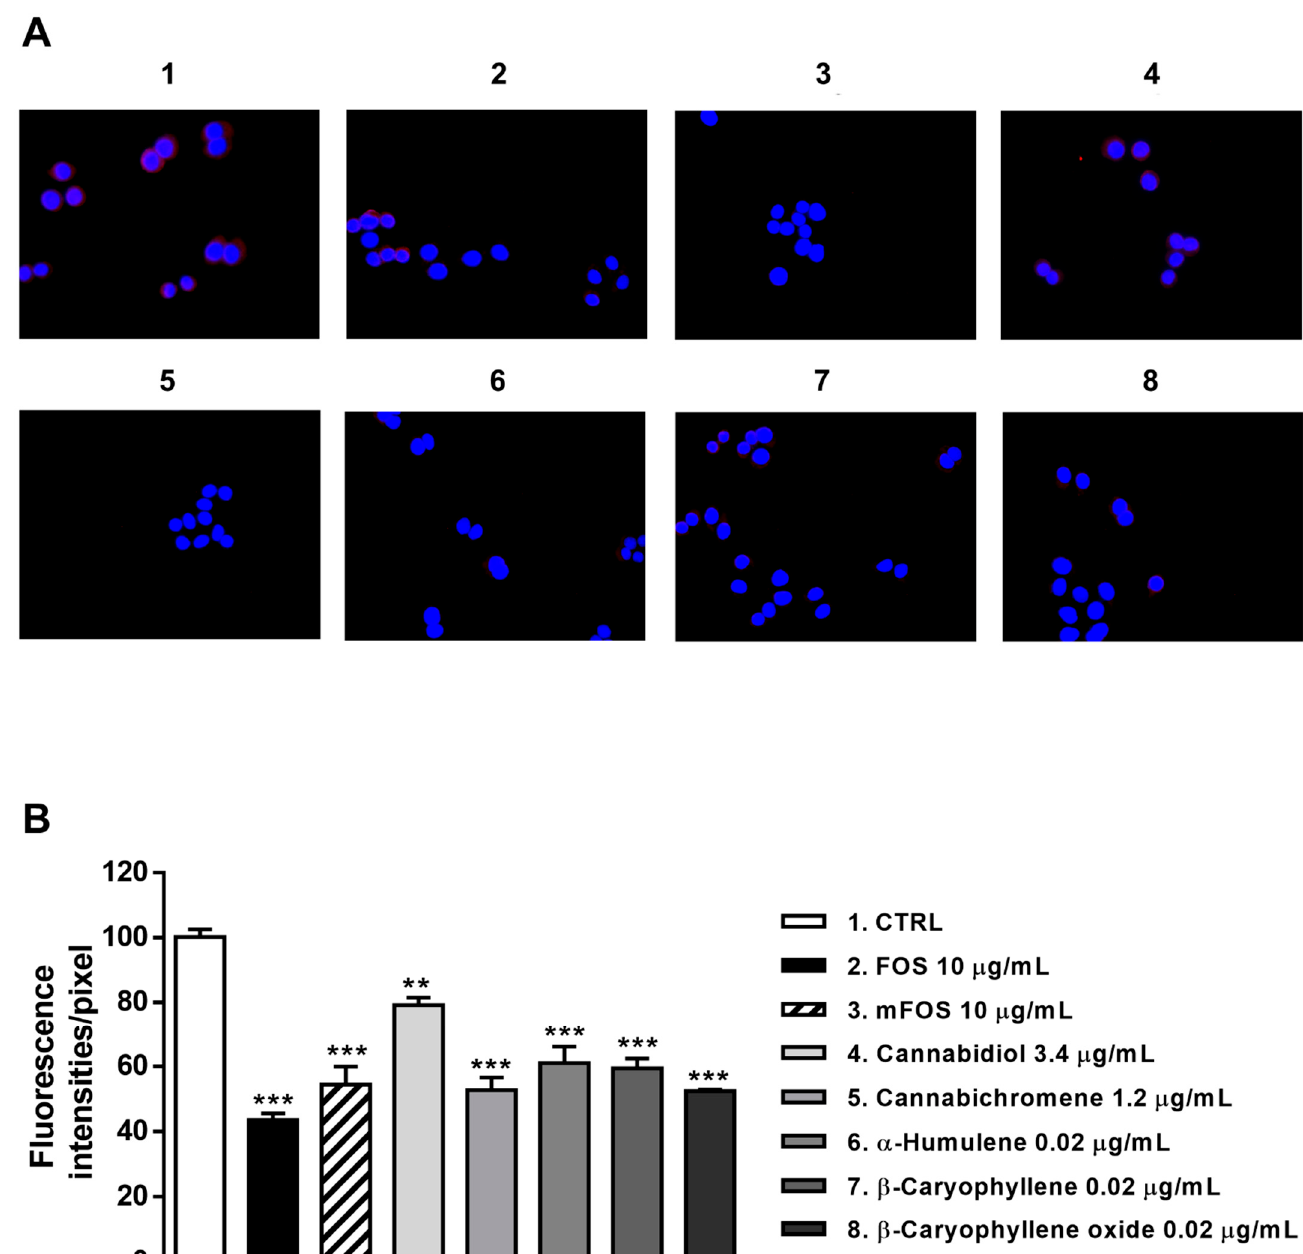
Figure 9. Modulation of CB2 receptor expression in MDA-MB-468 cells detected after 24 h treatment with 10 µg/mL FOS (organic extract from Felina 32 hemp inflorescences collected in September), the corresponding mFOS cocktail, and with the nonintoxicating phytocannabinoids and caryophyllane sesquiterpenes contained in FOS extract. ( A ) Representative images obtained at immunofluorescence analysis. ( B ) Densitometric analysis of immunofluorescence carried out by the free software ImageJ ( n = 6). ** p < 0.01 and *** p < 0.001, significant difference respect to the control (ANOVA + Dunnett’s Multiple Comparison PostTest). 1. Control; 2. FOS; 3. mFOS; 4. Cannabidiol, 3.4 µg/mL; 5. Cannabichromene, 1.2 µg/mL;